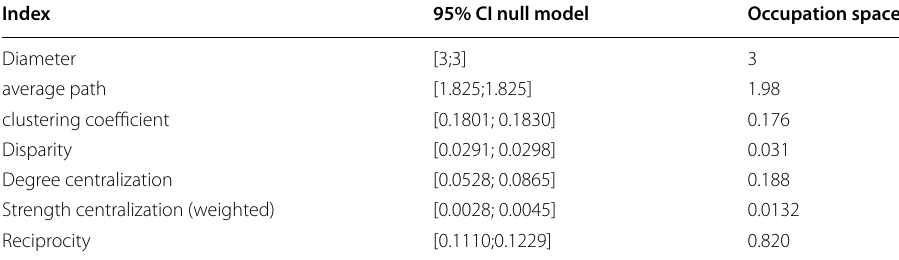
Table 1 Comparison of network structure: random versus occupation